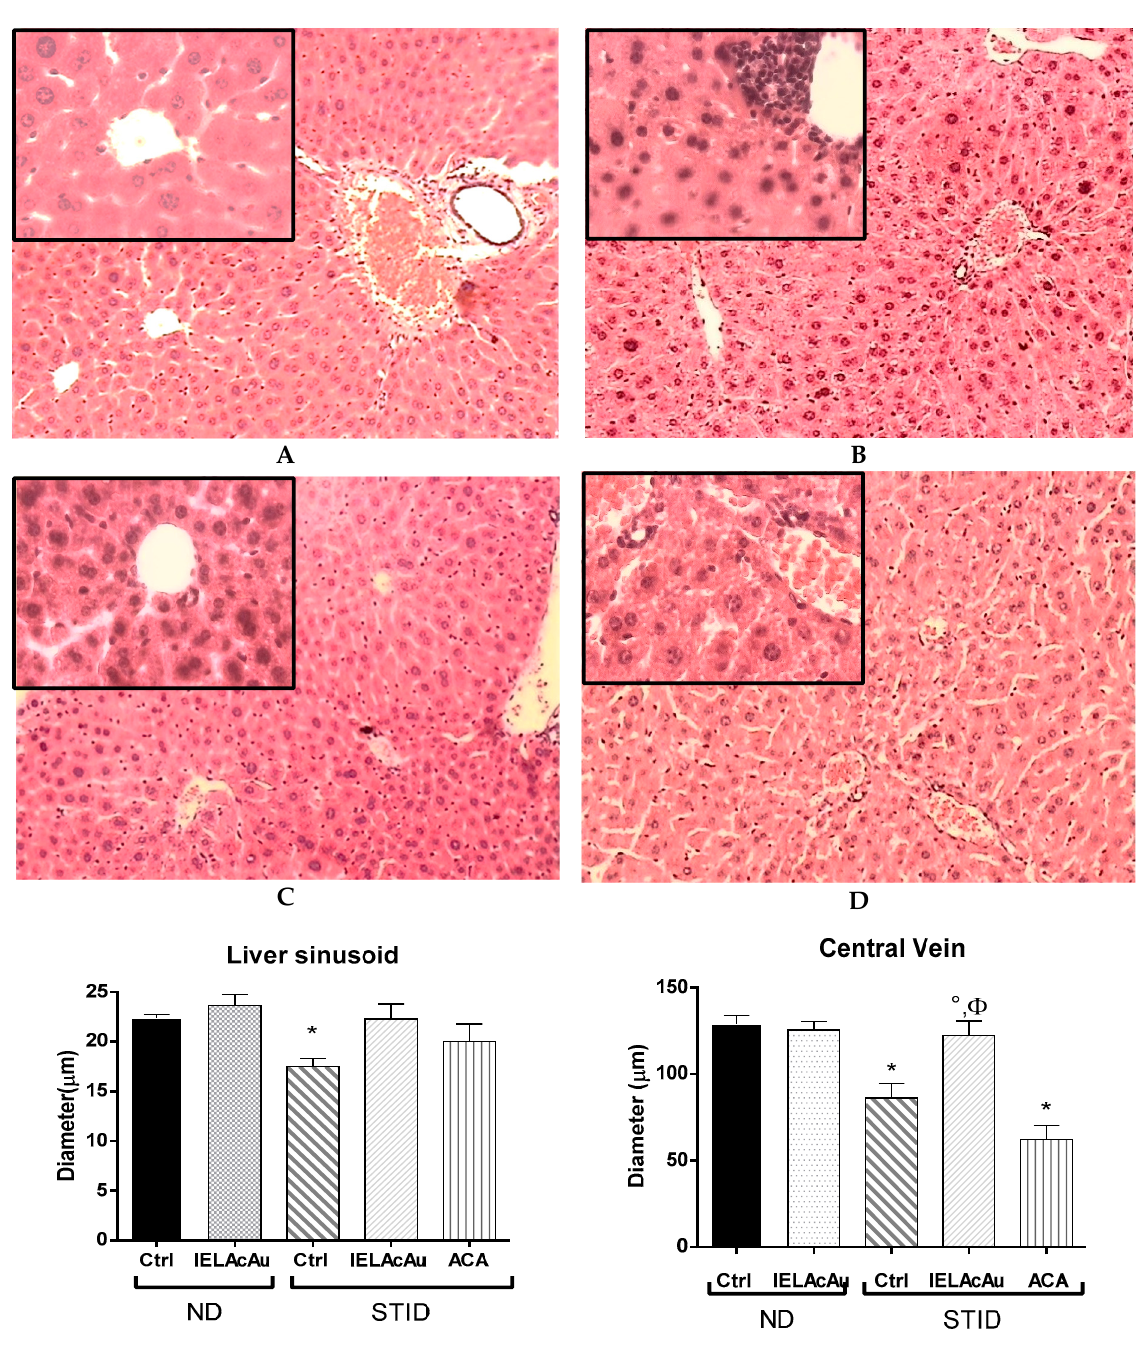
Figure 3. ( Top ) Representative photomicrographs with H&E staining of transversal liver sections after the administration for 28 days of IELAcAu in non-diabetic (ND) and streptozocin-induced diabetic (STID) mice. ( A ) ND control. ( B ) STID control. ( C ) STID with IELAcAu (300 mg/kg bw). ( D ) STID with acarbose (ACA) (50 mg/kg bw) (magnification 10 × and box 40 × ). ( Bottom ) Quantitative analysis of vascular diameter and sinusoids of liver sections. Results are expressed as the mean ± SEM, n = at least 9 fields in each group. * p < 0.05 vs. ND control; ° p < 0.05 vs. STID control; Φ p < 0.05 vs. acarbose.